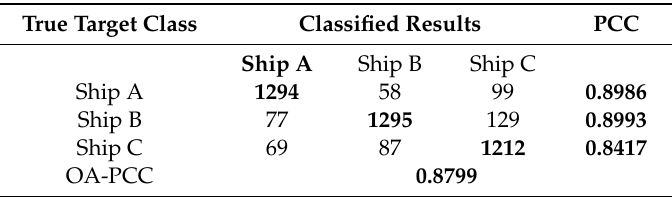
Table 1. Classification results of the ship